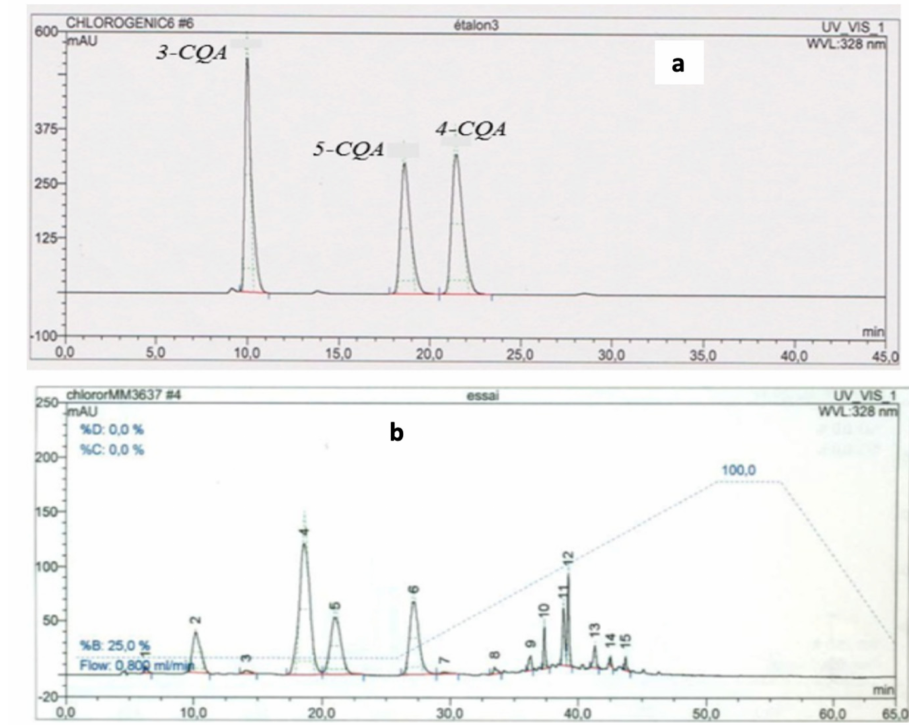
Figure 2. Gradient HPLC chromatograms of chlorogenic derivative acid standards ( a ) and phenolic acids on the methanol extract from the GSP fraction of potato samples ( b ). Stationary phase: column C18 Uptisphere HDO 120Å, 5 µ m, 250 × 4 mm. Mobile phase: Solvent A: Phosphoric Acid 2 mM. Solvant B: Methanol. Flow: 0.8 mL/min. Gradient conditions: 0–26 min 25% of A, 26–51 min 25–100% of B, 51–56 min 100% of B, 56–65 min 100–25% of